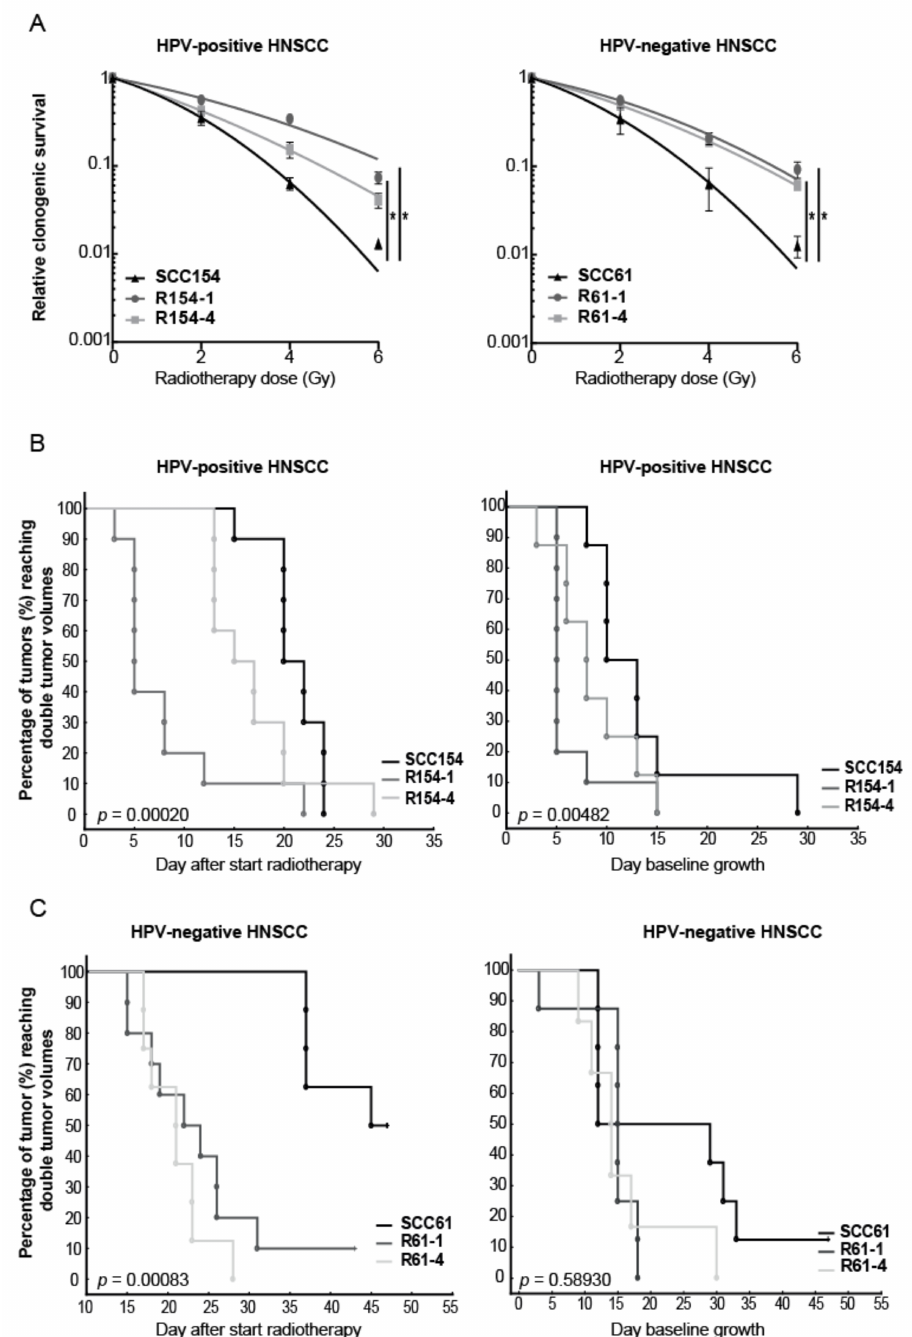
Figure 1. HPV-positive and HPV-negative HNSCC clones showed increased radioresistance in vitro and in vivo. ( A ) Clonogenic survival of HPV-positive and HPV-negative radioresistant clones was compared to their parental cell lines. Data are represented as the mean ± SEM for n = 3. Survival curves are fitted via the linear quadratic model. * p -values < 0.05 were calculated by extra sum- of-squares F-test. ( B , C ) Kaplan–Meier curves of HPV-positive and HPV-negative parental and radioresistant in vivo xenografts showed the percentage of tumors reaching double tumor volume. RT dose was given in a fractionated manner with 2 Gy fraction for 3 and 5 consecutive days for HPV-positive and HPV-negative models, respectively. All HPV-positive irradiated and unirradiated groups consisted of 10 tumors. HPV-negative SCC61, R61-1 and R61-4 irradiated groups contained 8, 10 and 8 tumors respectively. HPV-negative SCC61, R61-1 and R61-4 unirradiated groups contained 8, 8 and 6 tumors respectively. Statistics were performed by chi-square